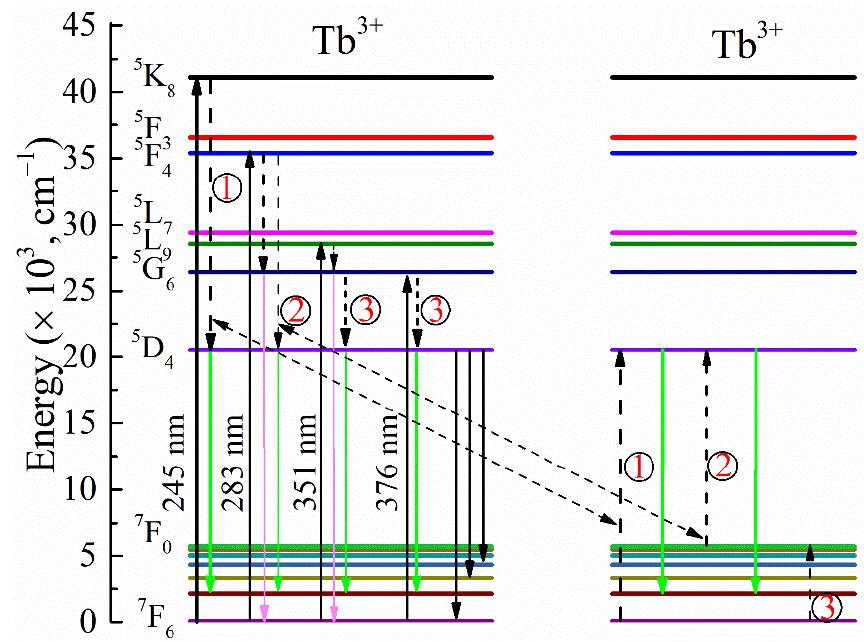
Figure 4. Energy level diagram of KYC:Tb 3+.